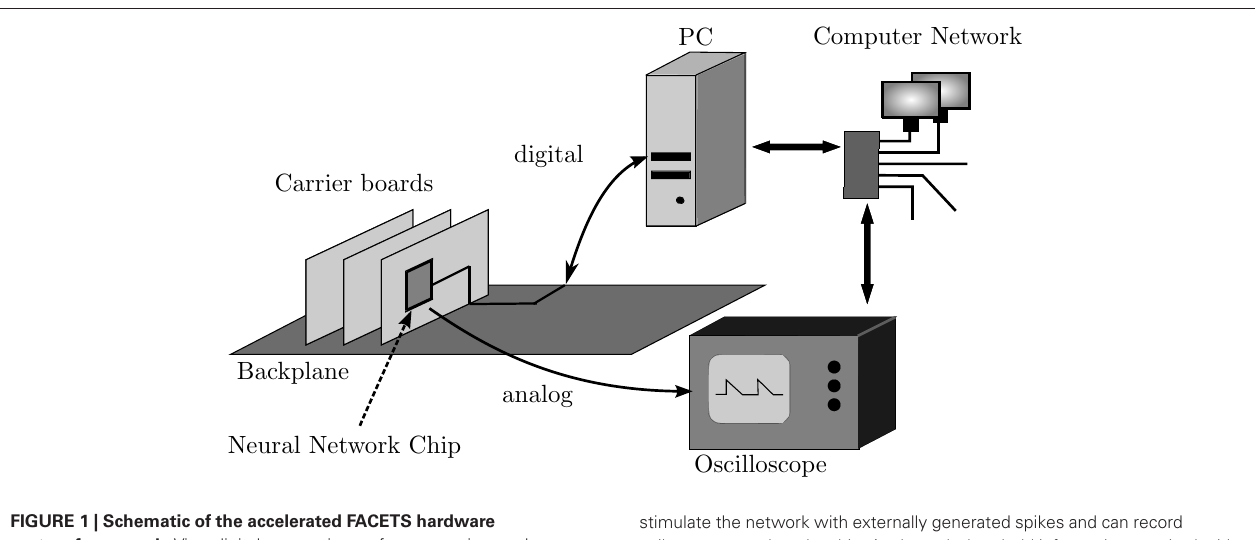
stimulate the network with externally generated spikes and can record spikes generated on the chip. Analog sub-threshold information acquired with an oscilloscope can be integrated into the software via a network